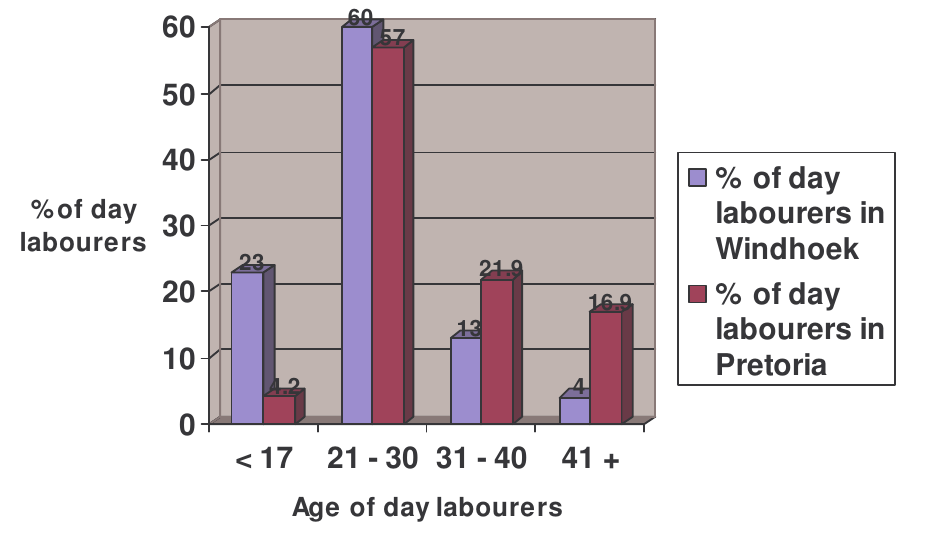
Figure 1: The age distribution of day labourers in Pretoria in 2004 and Windhoek in 2003